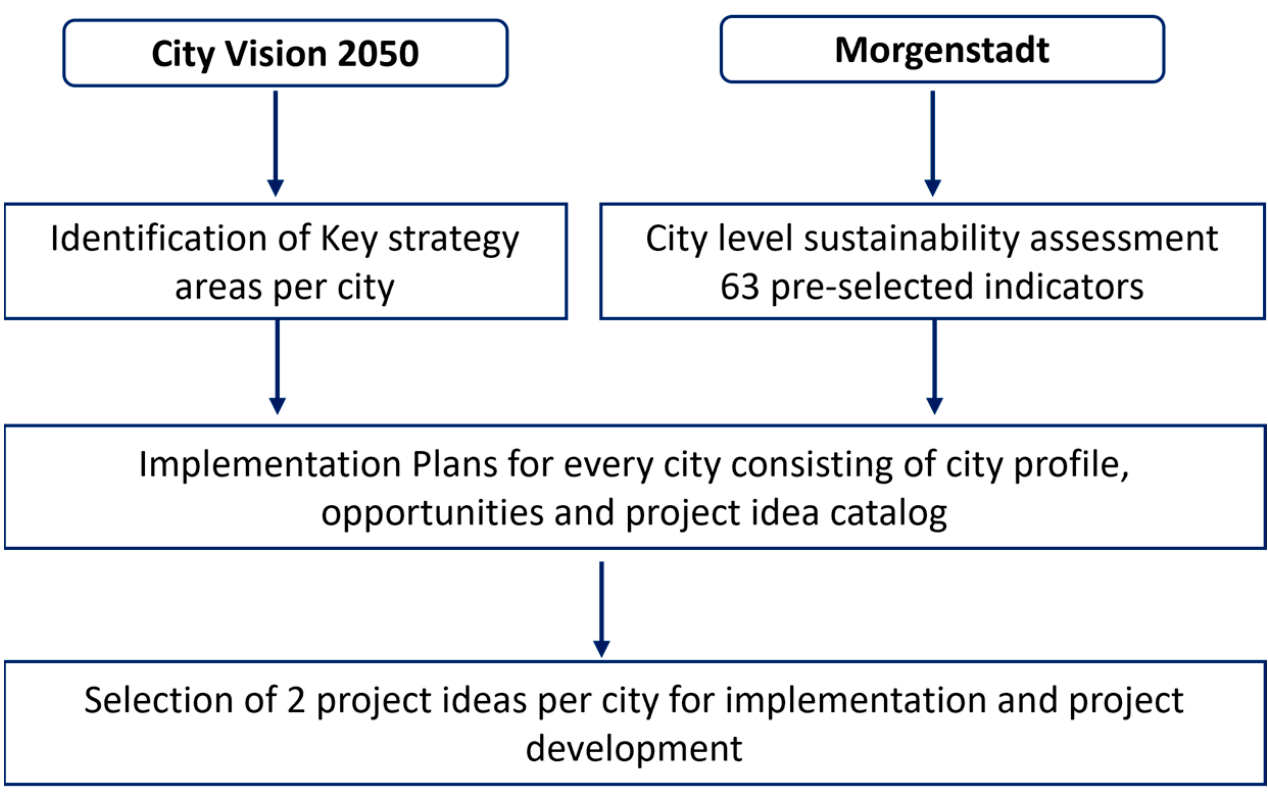
Figure 1. Method used to decide the solutions per city.